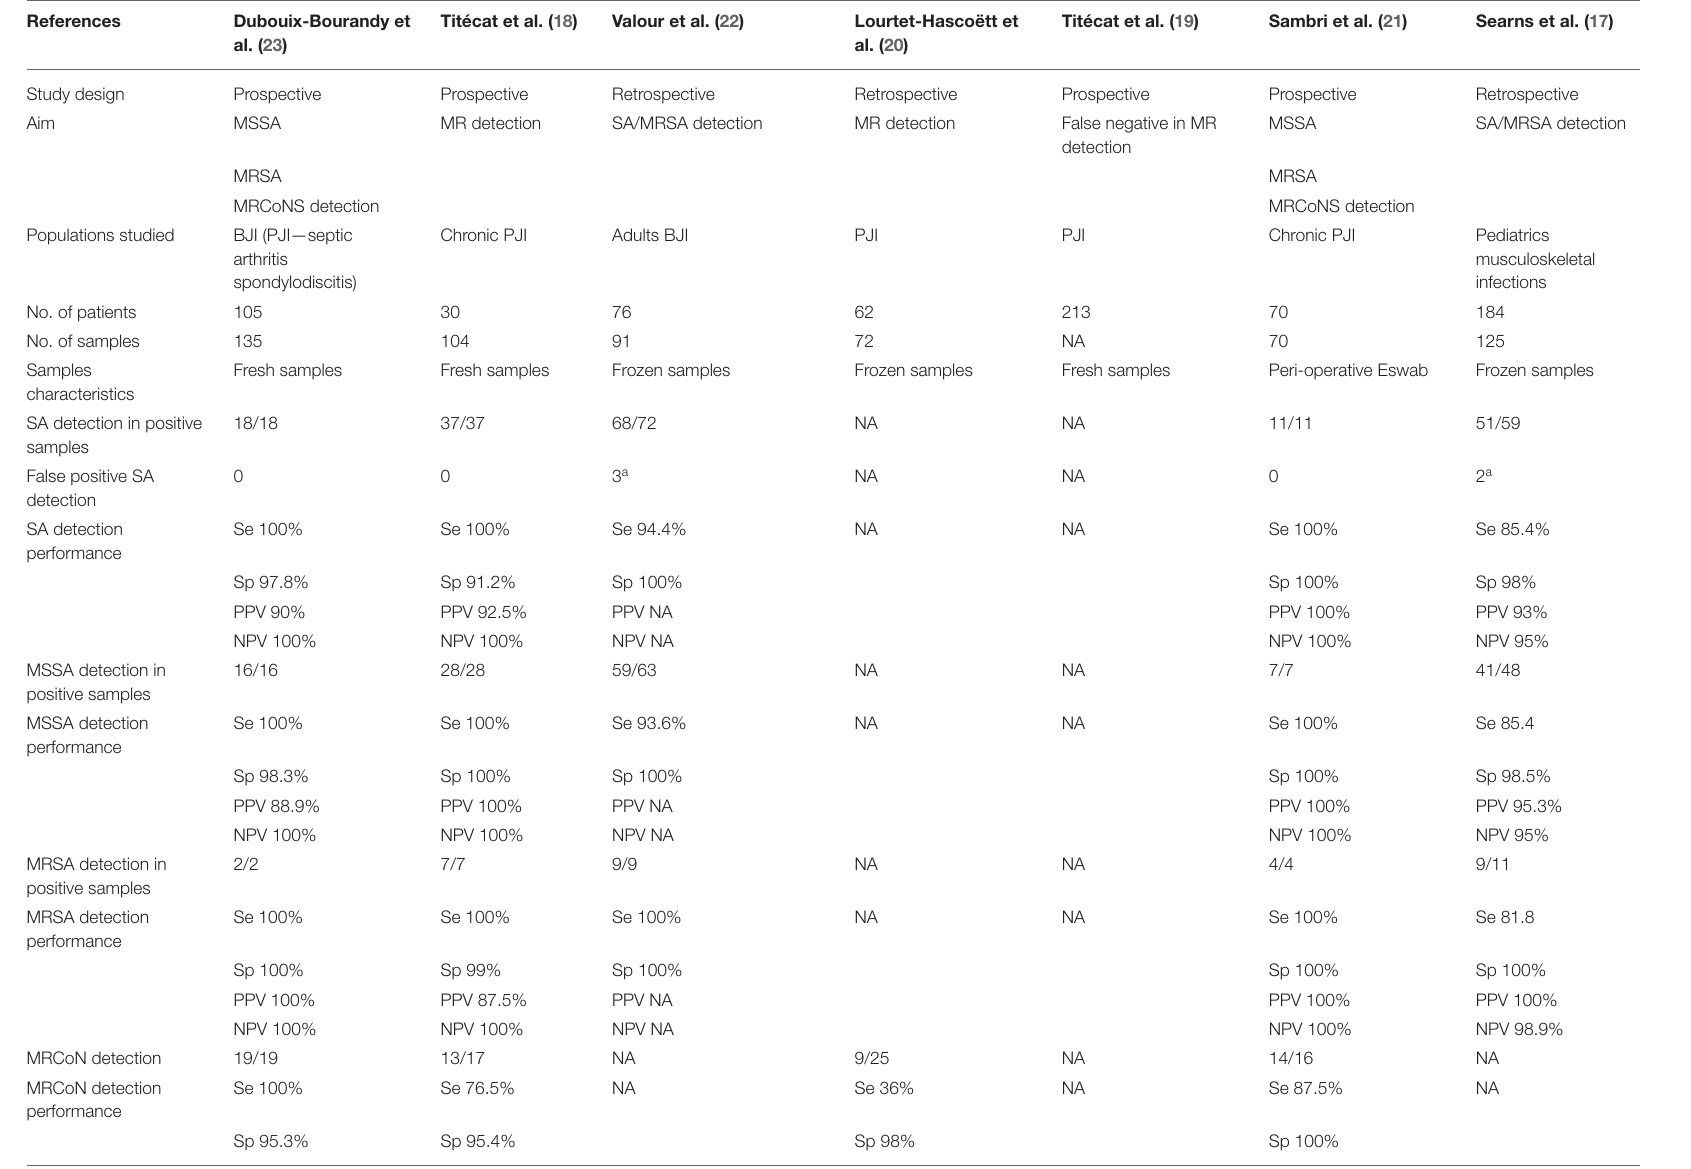
TABLE 1 | Comparison of studies evaluating the GeneXpert MRSA/SA SSTI ® in BJI